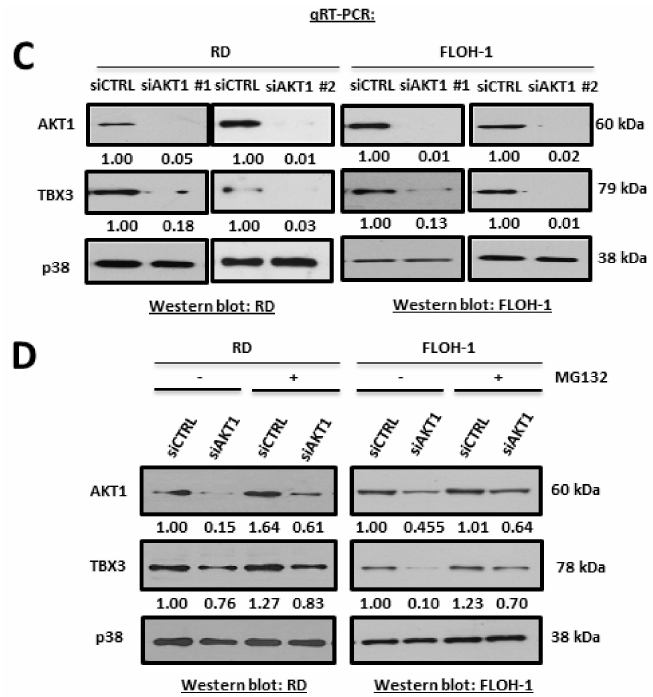
Figure 6. AKT1 is the predominant AKT isoform in ERMS and post-translationally upregulates TBX3 in ERMS. ( A ) RD (left) and FLOH-1 (right) cells were treated with 10 µ M of AKT inhibitor (AKT VIII) or vehicle (V; DMSO) for 1, 2 and 4 h. Protein extracts were subjected to Western blot analyses with the indicated antibodies. ( B ) qRT-PCR of cDNA extracted from indicated RMS cell lines cells using primers specific to AKT1, AKT2 and AKT3 and β -Actin (housekeeping gene) and mRNA levels were normalised to β -Actin and quantified relative to the RD cell line. The values in the graph represent the mean of at least three independent experiments ± SEM (* p < 0.05; ns, not significant). ( C ) RD (left)and FLOH-1 (right) cells were transiently transfected with 50 nM siAKT1 #1 for both cell lines or 25 nM and 75 nM siAKT1 #2 for RD and FLOH-1 cells, respectively, or the equivalent concentrations of siCTRL for 48 h. Protein extracts were subjected to Western blot analyses with the indicated antibodies. ( D ) RD and FLOH-1 cells were transfected with siCTRL and siAKT1 for 42 h then treated with the proteasome inhibitor 20 µ M MG132 for 30 min, protein was extracted and subjected to Western blotting using the indicated antibodies. Densitometric readings for all Western blots were calculated relative to the p38